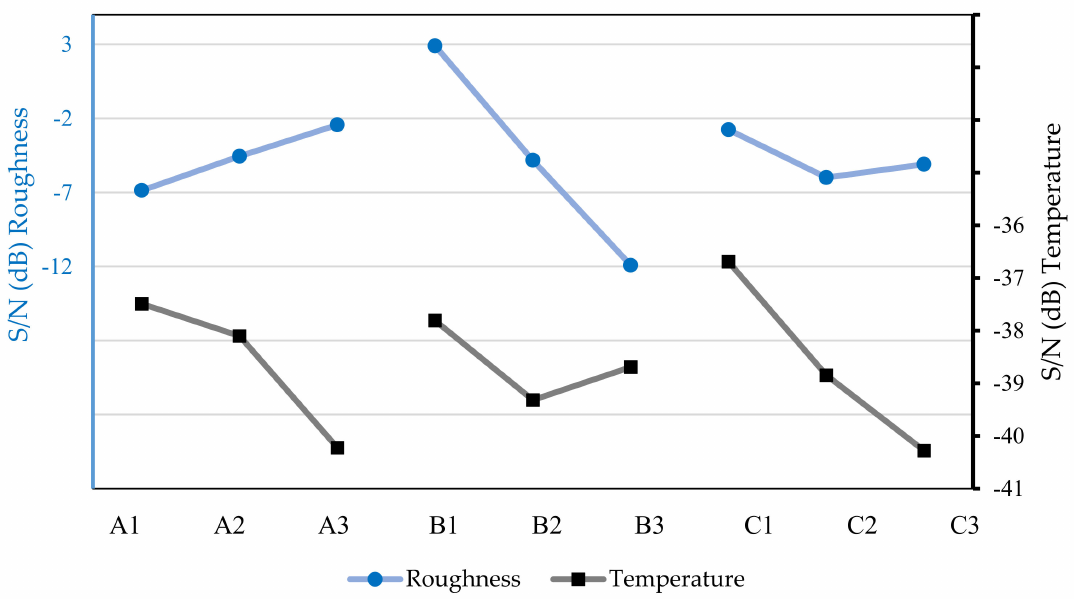
Figure 9. S/N values for surface roughness of the workpiece and chip temperatures based on the machining tests with vegetable oil (100 mL/h).